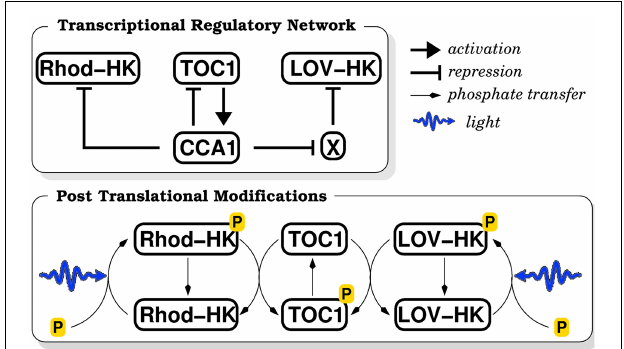
FIGURE 1 | Schematic diagram of the biochemical reaction network. The upper panel recapitulates the transcriptional regulations (activation or repression) between molecular actors. The lower panel summarizes the post-translational modifications induced by the phosphate transfer